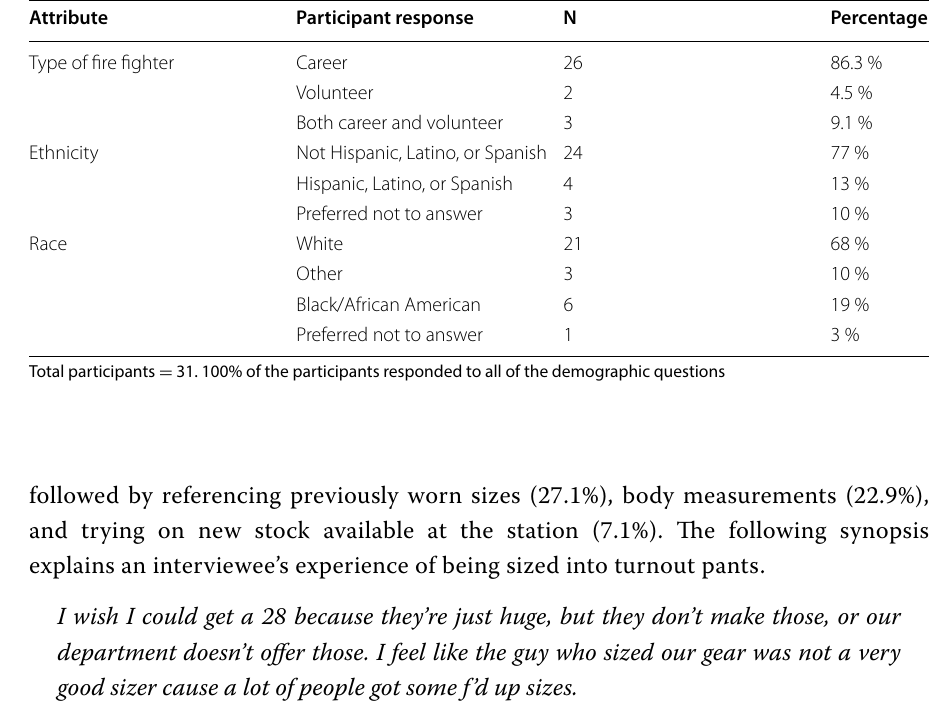
31. 100% of the participants responded to all of the demographic questions